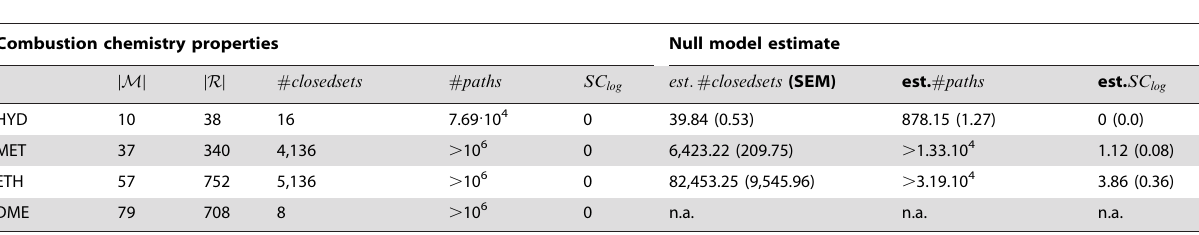
Combustion chemistry